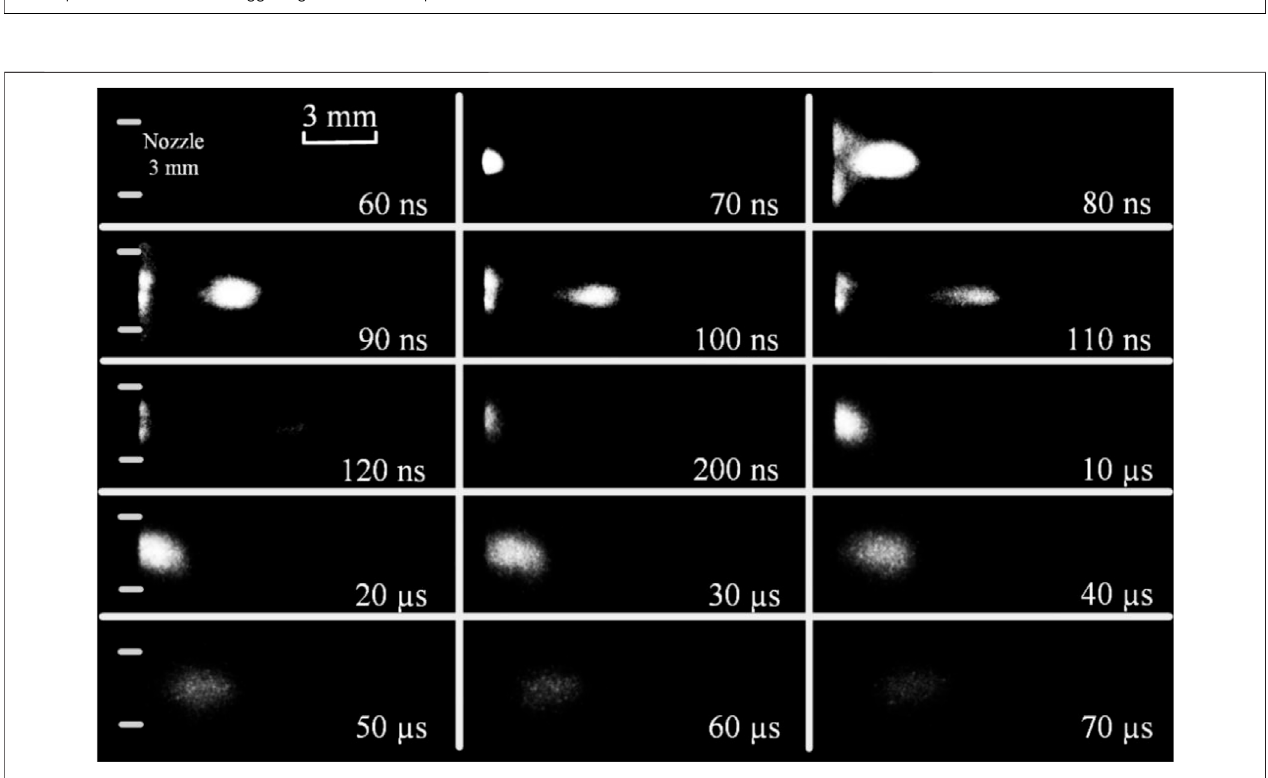
FIGURE 6 | Dynamics photos of the air plasma jet with a 3-mm diameter nozzle in the afterglow region. The exposure time is 3 ns in 60~120 ns and 1 μ s in 120~70 µs, respectively. The time that the external trigger signal gives the camera to start taking pictures is marked in each photo ’ s bottom right.